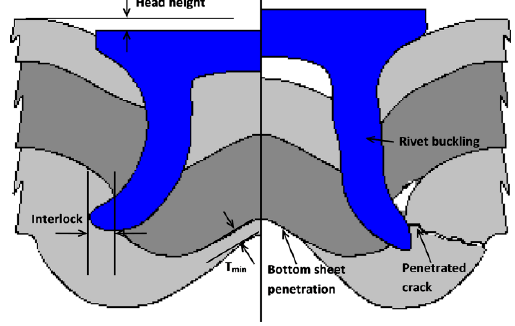
Figure 9. SPR joint quality and some faults